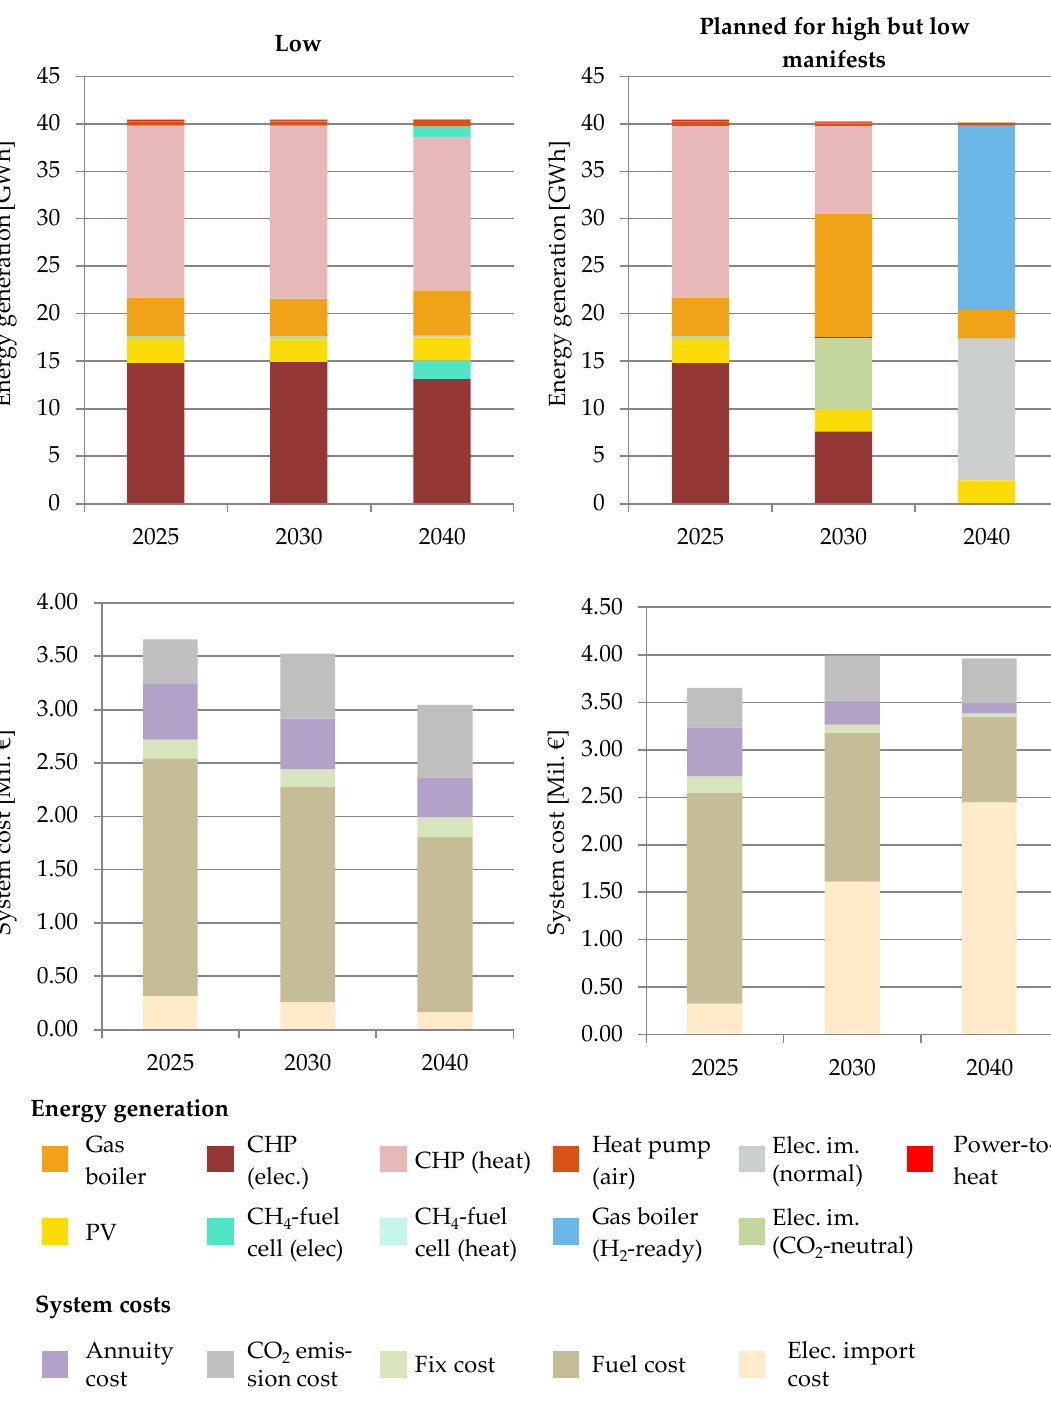
Figure 12. Energy generation and costs for the low and “planned for high but low manifests” scenarios (myopic, without CCS).